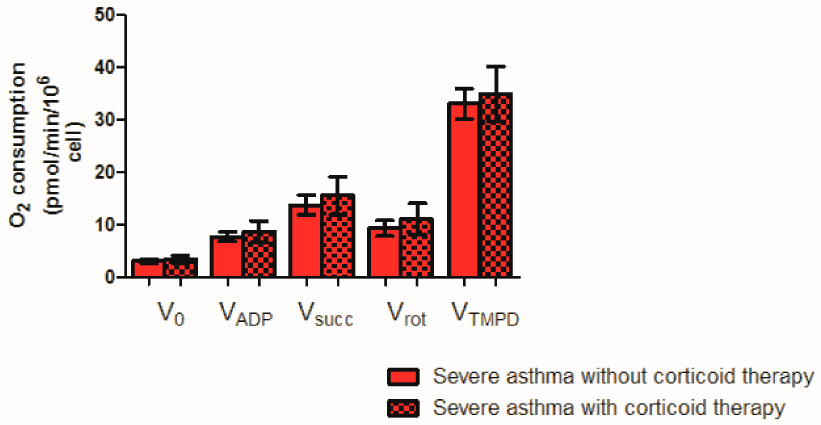
Figure 2. PBMC mitochondrial respiration in severe asthmatic patients treated or not with